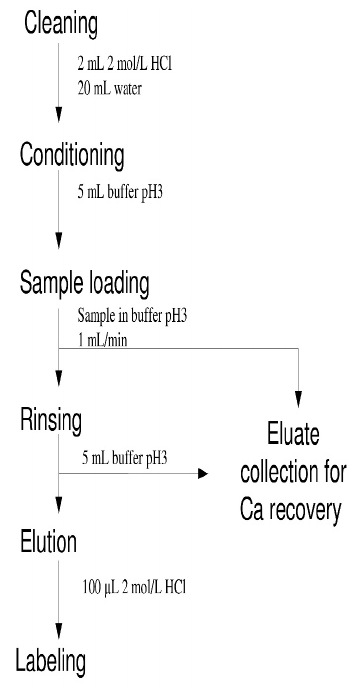
Figure 4. Flowchart of operations for target processing and scandium separation.